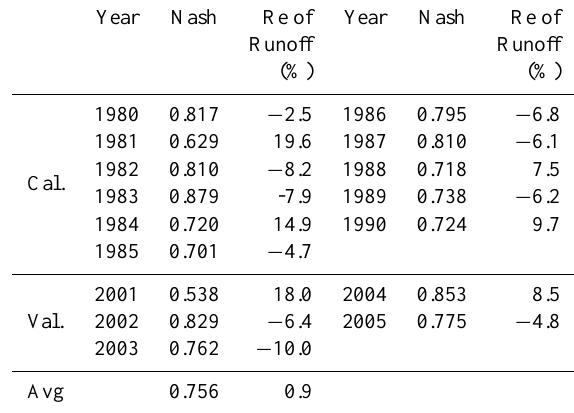
Table 3. Results of hourly flood simulation at the Huangnizhuang station by REW approach.